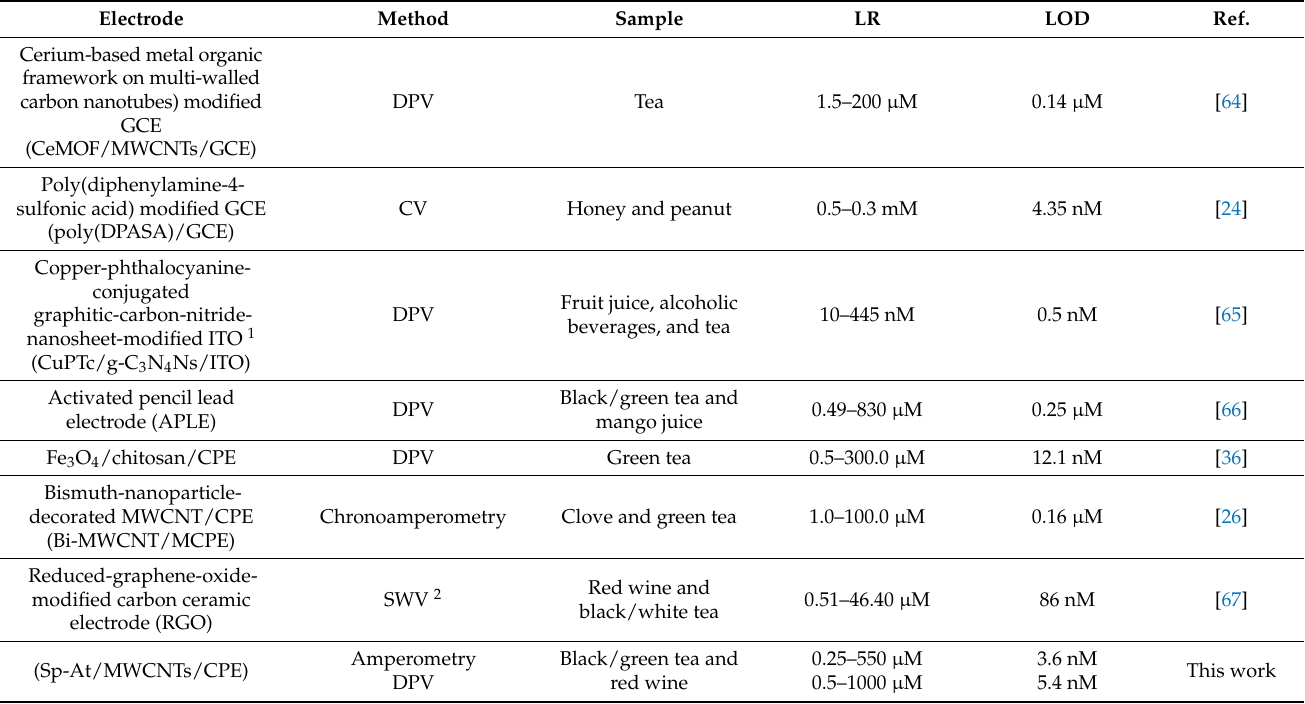
Table 2. Comparison between various electroanalytical methods for the determination of GA in real